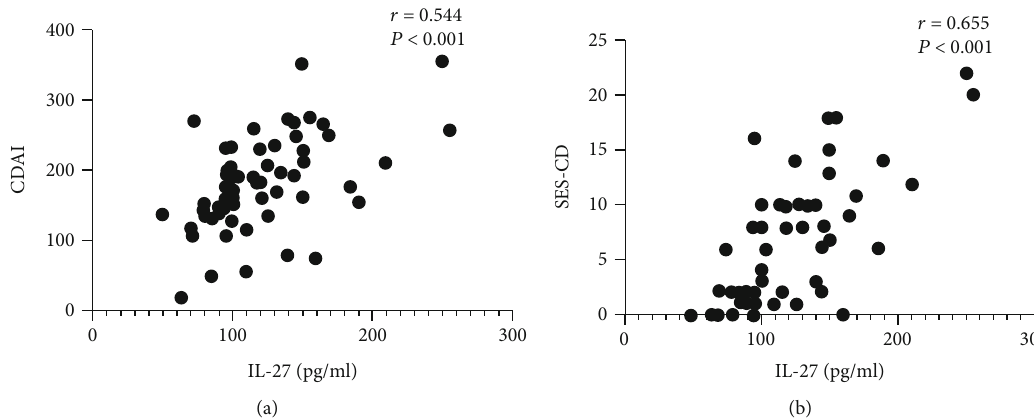
Figure 2: Correlation analysis between serum IL-27 levels and clinical and endoscopic activity scores in all CD patients ( n = 60 ). (a) Correlation of serum IL-27 levels with Crohn ’ s disease activity index (CDAI). (b) Correlation of serum IL-27 levels with Simple Endoscopic Score for Crohn ’ s Disease (SES-CD). Spearman ’ s rank correlation test was used to assess the correlations.